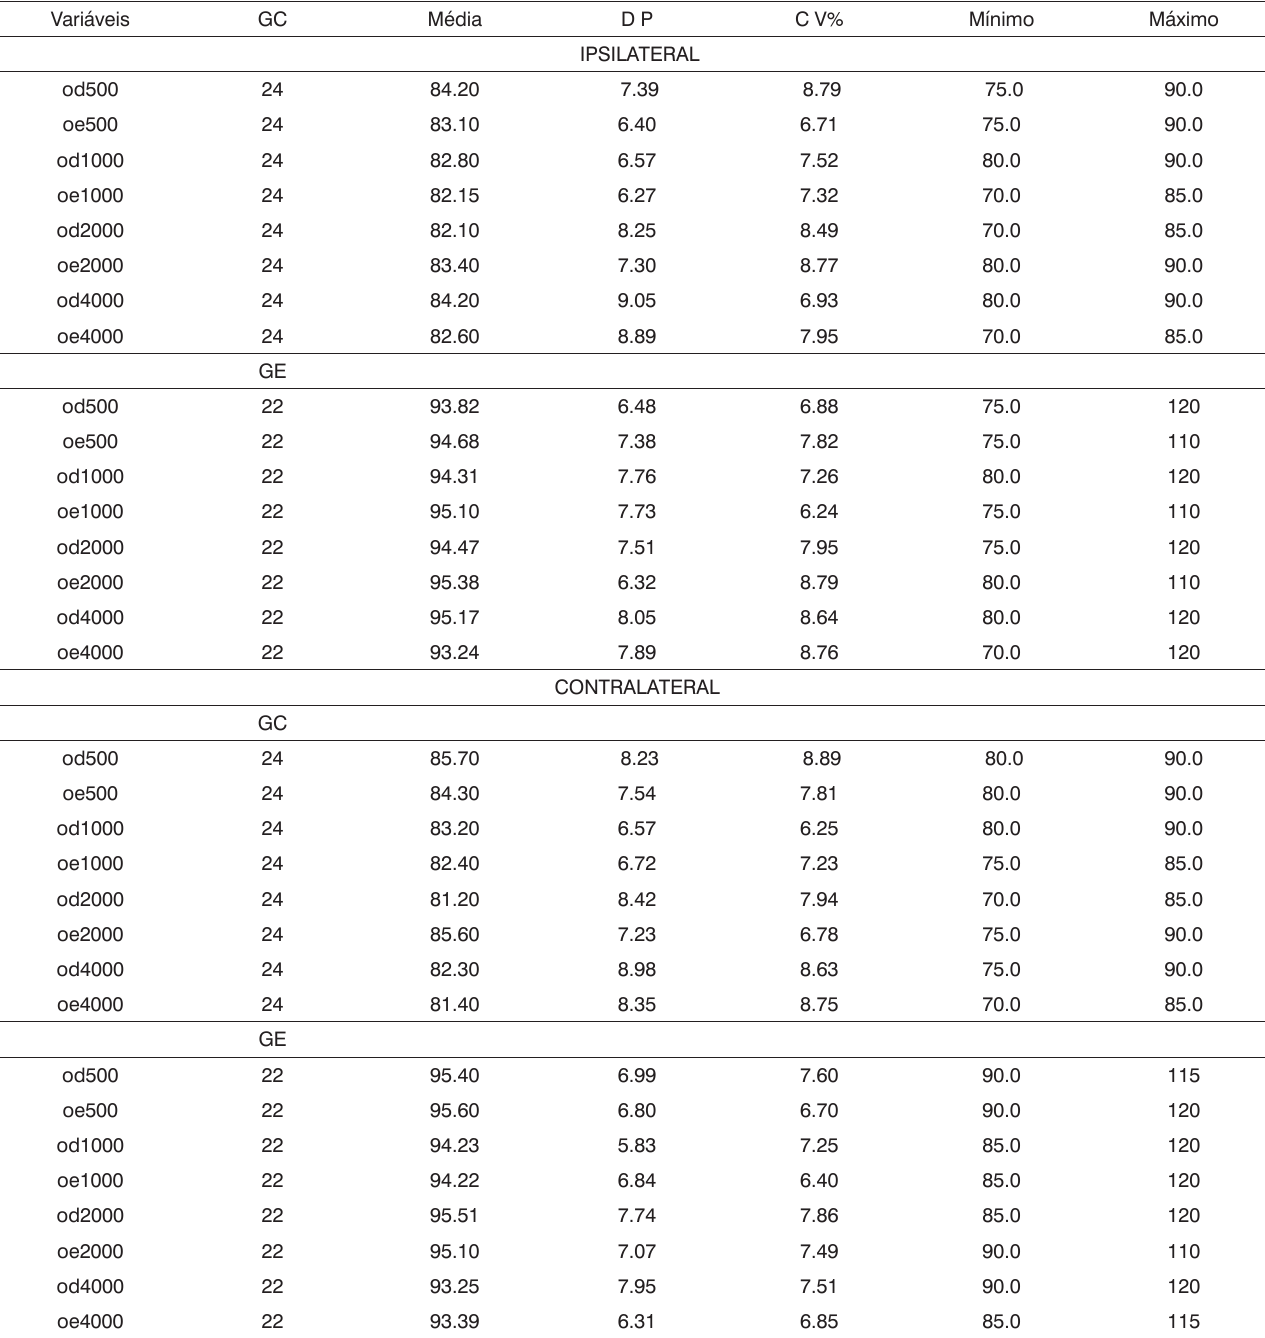
Tabela 2. Resultados da avaliação do reflexo acústico ipsilateral e contralateral dos grupo controle GC e GE.